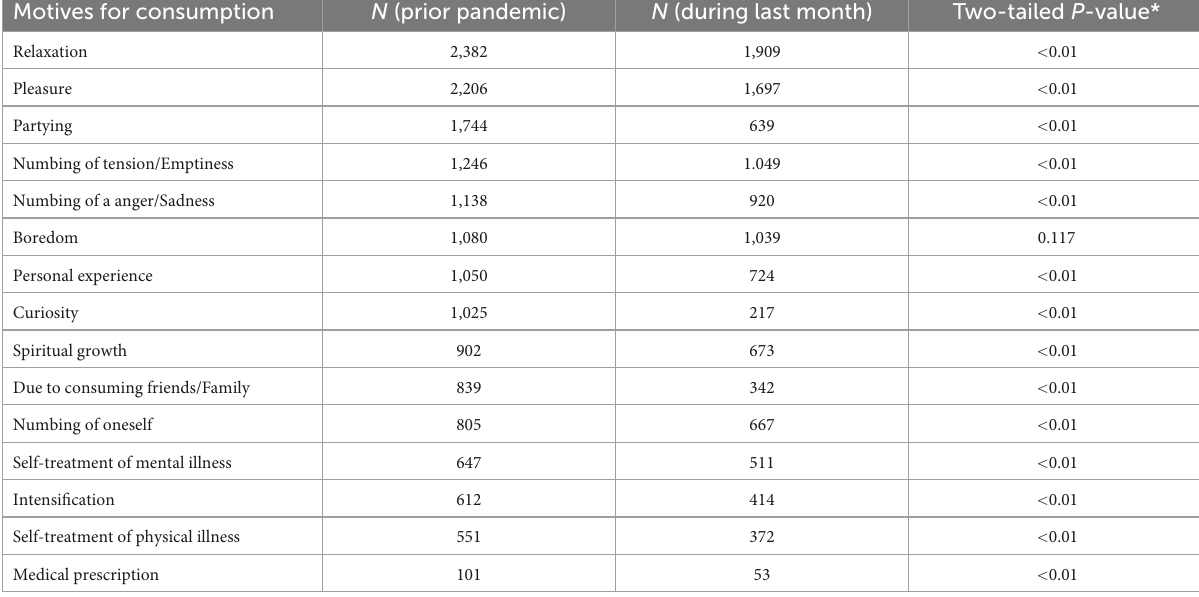
TABLE 5 Rationales for cannabis consumption prior versus during the pandemic. Motives for